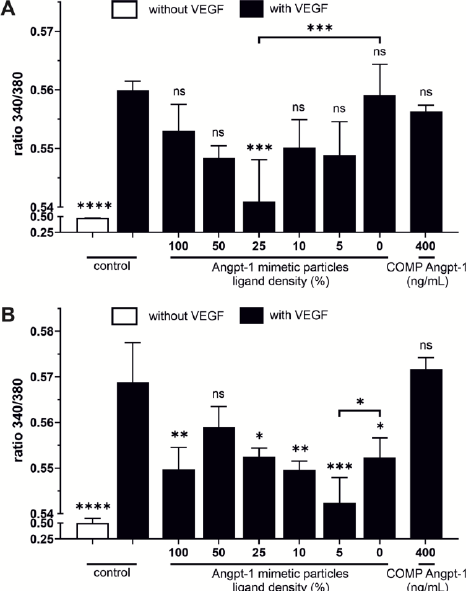
Figure 5. Angpt-1 mimetic NPs reduced VEGF-induced Ca 2+ influx in endothelial cells. Cells were loaded with fura-2 AM for 2 h. Fura-2 AM allows for precisely measuring the intracellular concentration of Ca 2+ . After cell loading, HUVECs ( A ) and EA.hy926 cells ( B ) were incubated with Angpt-1 mimetic NPs (150 pM) of varying ligand density (100% to 0%) or COMP Angpt-1 at a concentration of 400 ng/mL, both in presence of VEGF. A concentration of 400 ng/mL for COMP Angpt-1 was chosen because it is in the range of concentrations usually used in the literature [11,27–29]. Presented is the Ca 2+ -dependent ratio of fluorescence emission of fura-2 AM at 510 nm after excitation at 330 and 380 nm, respectively. Angpt-1 mimetic particles opposed VEGF-induced Ca 2+ influx in both HUVECs and EA.hy926 cells. Results are presented as mean ± SD of at least n = 3 measurements. * p < 0.05, ** p < 0.01, *** p < 0.001, **** p < 0.0001 ns: not significant. Y -axes are discontinued between 0.50 and 0.54 ( A , B